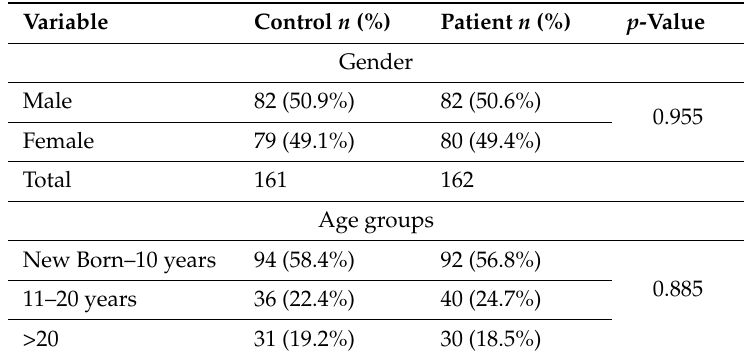
Table 2. General characteristics of the participants.